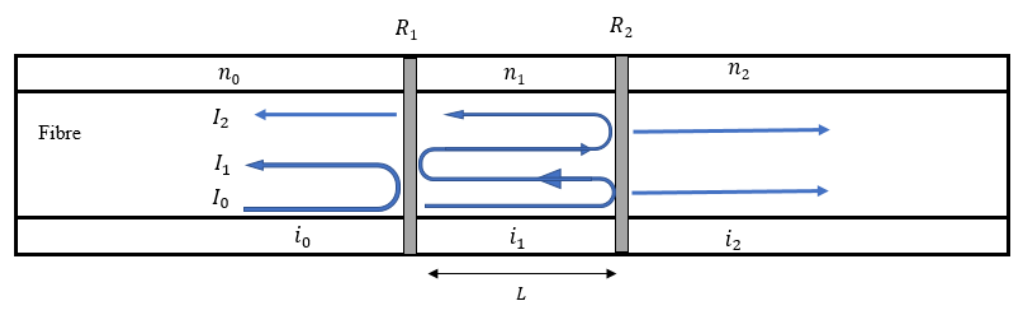
Figure 6. Fiber Bragg Grating (FBG) spectrum simulation, numerical vs. experimental results. Table 1. Fiber Bragg Grating (FBG) sensor parameters.